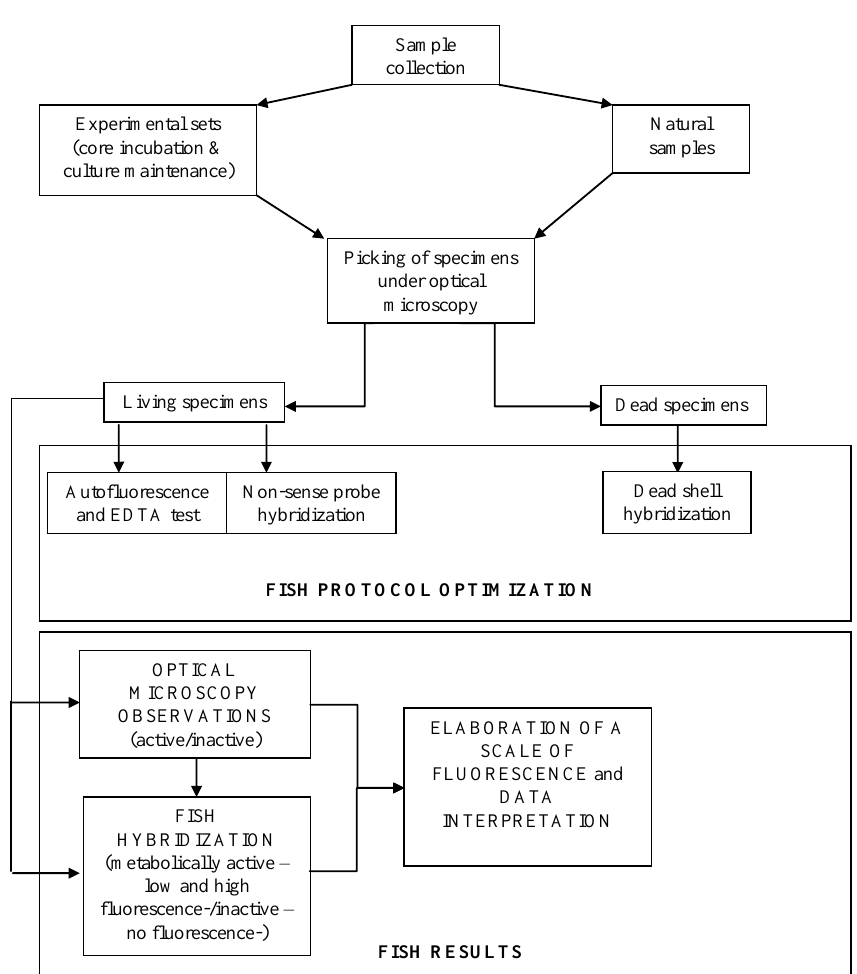
Fig. 1. General scheme of the experimental design to test our FISH protocol. See text for details.